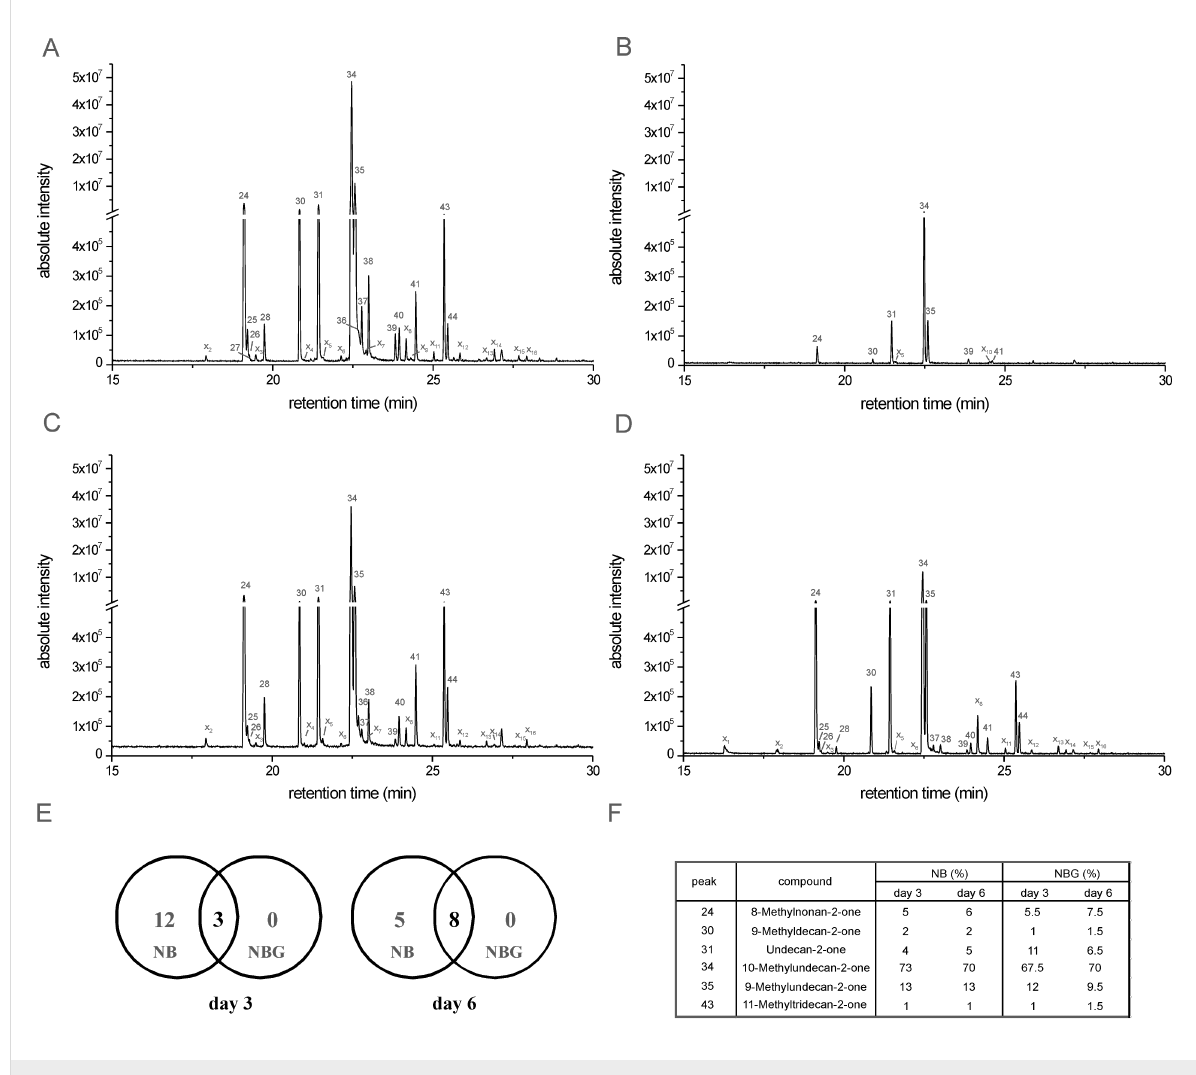
Figure 5: GC/MS analysis of volatiles emitted by Xanthomonas campestris pv. vesicatoria 85-10 grown on different media. (A) GC/MS-profile of headspace volatiles of X. c. pv. vesicatoria 85-10 grown on NB at day 3. (B) GC/MS-profile of headspace volatiles of X. c. pv. vesicatoria 85-10 grown on NBG at day 3. (C) GC/MS-profile of headspace volatiles of X. c. pv. vesicatoria 85-10 grown on NB at day 6. (D) GC/MS-profile of headspace volatiles of X. c. pv. vesicatoria 85-10 grown on NBG at day 6. (E) Registration of volatiles reaching a threshold level >1 × 10 5 when X. c. pv. vesica- toria 85-10 grew on NB (left circle) and NBG (right circle) (day 3: left panel, day 6: right panel). (F) Relative contribution (%) of the six major volatiles emitted by Xanthomonas campestris pv. vesicatoria 85-10 at day 3 and 6 grown on NB and NBG.